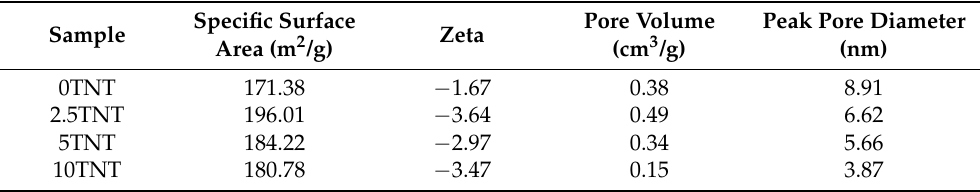
Table 1. BET measurement of the selected